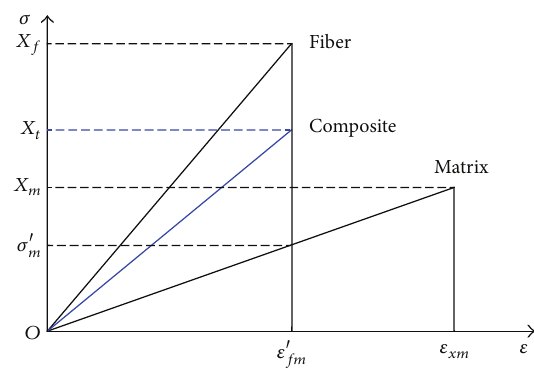
Figure 1: Stress strain curve of the fiber and matrix.